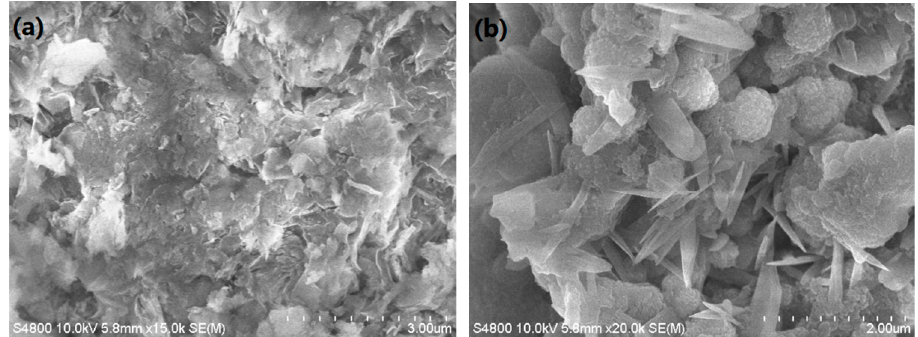
Figure 2. SEM(scanningelectronmicroscopy)imagesofthe( a )purifiedACand( b Figure 2. SEM (scanning electron microscopy) images of the ( a ) purified AC and ( b ) Ln@AC nanocomposite.